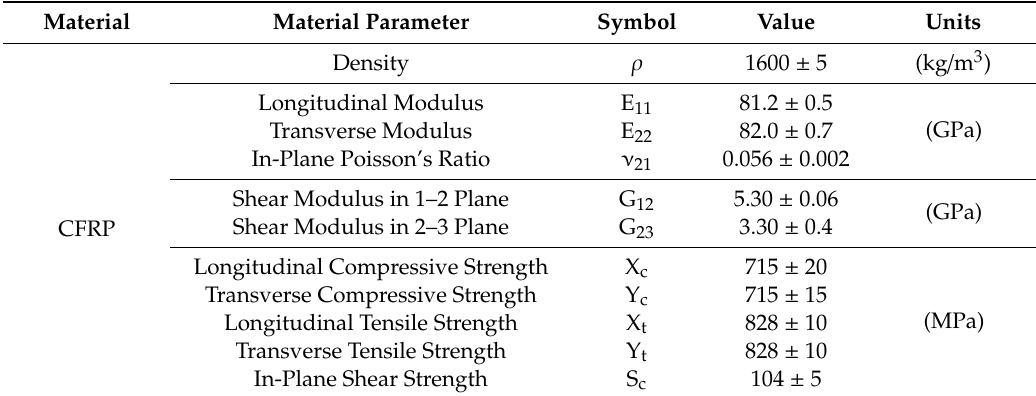
Table 1. Properties of carbon fiber / epoxy